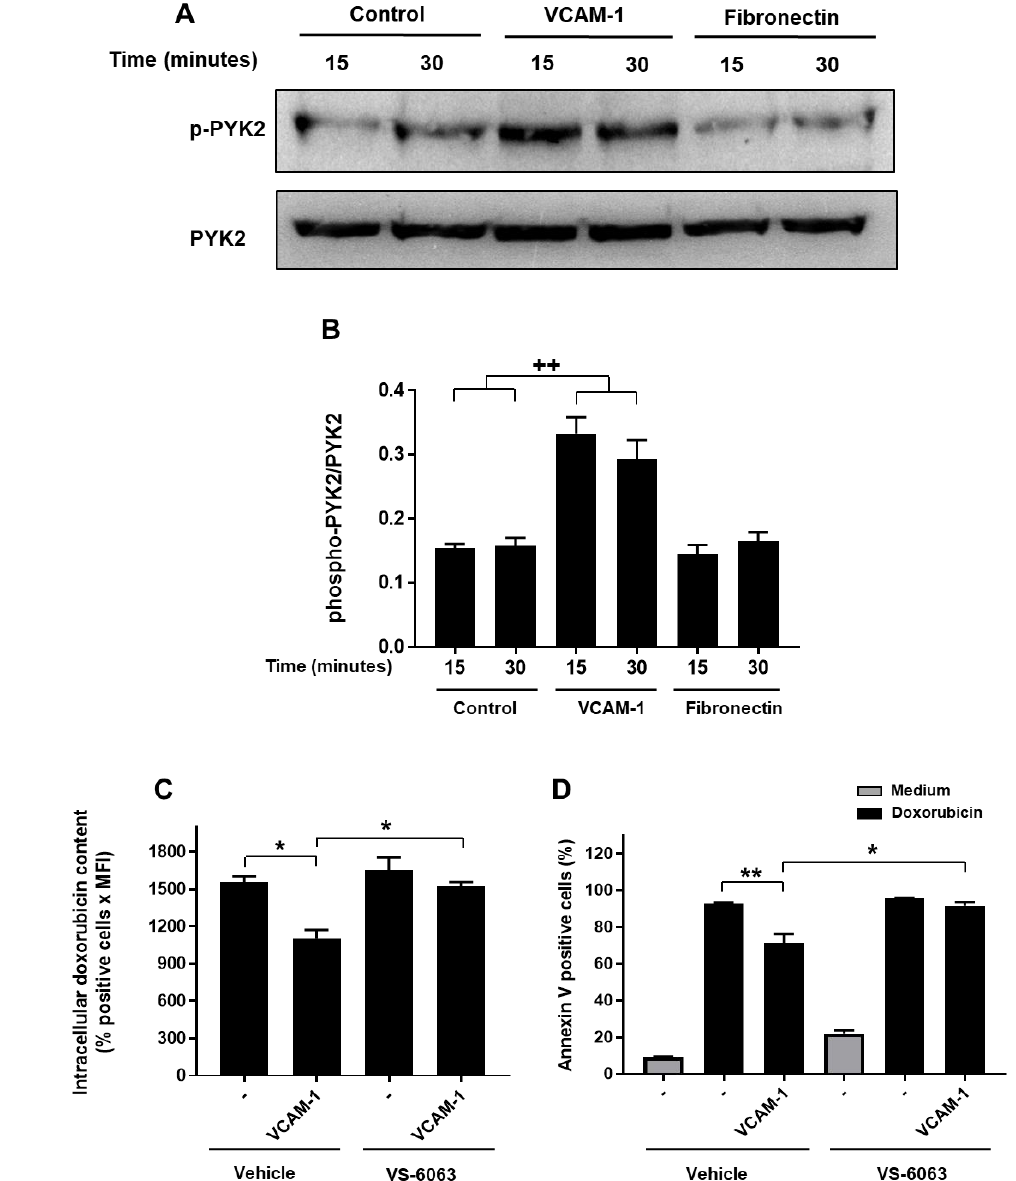
Figure 7. VCAM-1 induces doxorubicin resistance in a PYK2-dependant manner. ( A ) VCAM-1 but not fibronectin induces PYK2 phosphorylation. Jurkat cells were seeded on VCAM-1 or fibronectin for 15 min and 30 min or on BSA ( − ) for 15 min. The cells were then lysed and cell lysates were analyzed by Western blot with anti-phosphorylated PYK2 (Tyr-402) antibody. The immunoblots were stripped and re-probed with total anti-PYK2 antibody to ensure equal loading. Representative immunoblot from three independent experiments. ( B ) Densitometric quantification of PYK2 activation was determined by the ratios between the levels of phosphorylated-PYK2 and total PYK2 (n = 3). ( C ) PYK2 inhibition blocks doxorubicin efflux induced by VCAM-1. Jurkat cells were treated with vehicle or with the PYK2 inhibitor VS-6063 (0.5 µM) for 1 h and then seeded on VCAM-1 for 4 h. The adhered cells were then treated for 2 h with 100 ng/mL of doxorubicin and intracellular doxorubicin content was determined by FACS analysis. ( D ) PYK2 inhibitor abrogates the protective effect of VCAM-1. The cells were treated as in ( C ) and apoptosis was determined after 48 h of treatment with 50 ng/mL of doxorubicin by annexin V staining and FACS analysis. Results represent mean values ± S.D. of three independent experiments. * p < 0.05 and ** p < 0.01 were determined by the Student’s t -test. ++ p < 0.01 determined by the two-way ANOVA